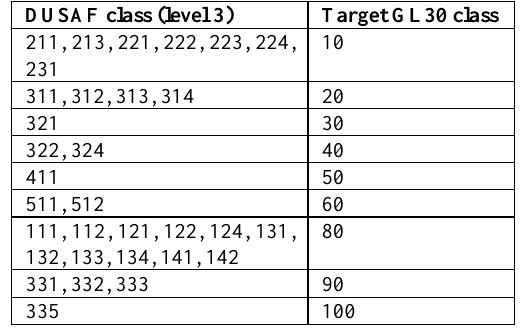
Table 3. Reclassification rules adopted in the conversion